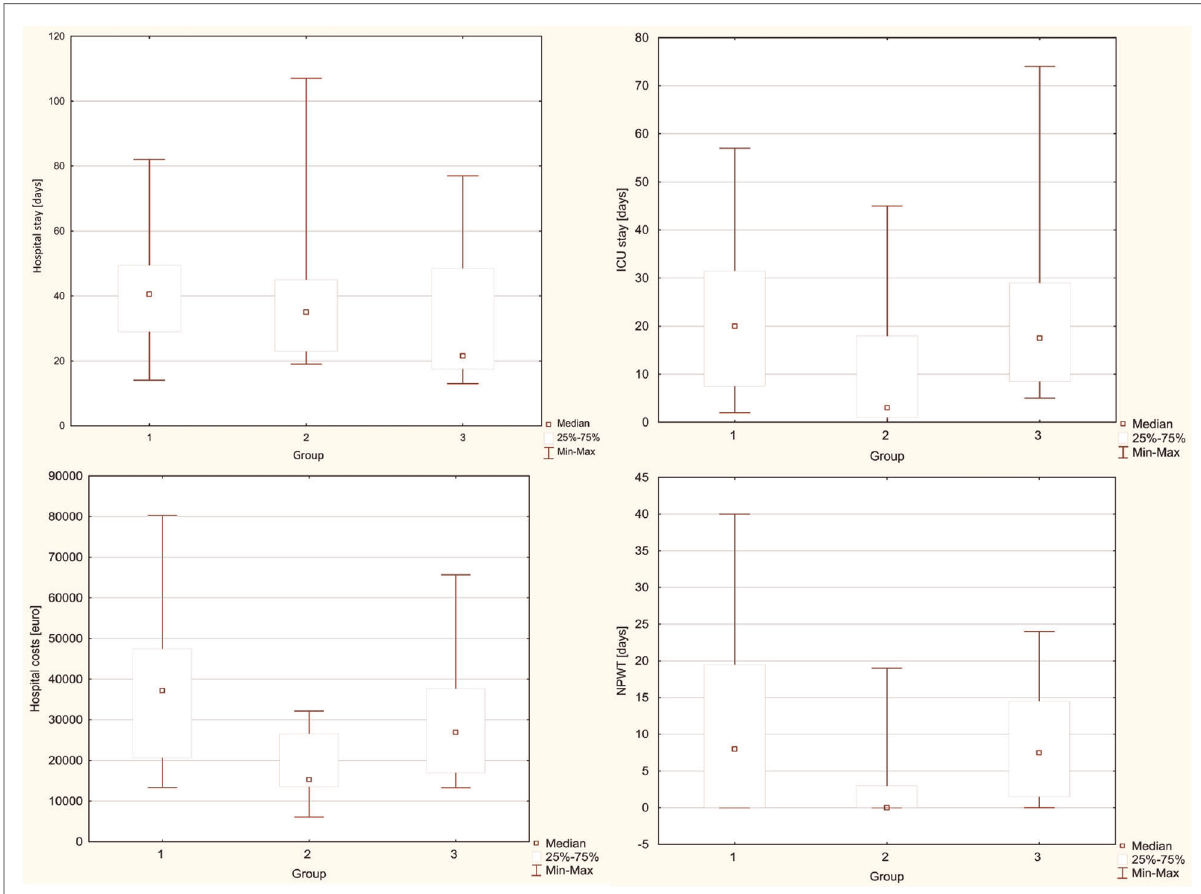
FIGURE 1 Boxplots comparing the individual monitored parameters between the groups. Group 1: PJA disconnection group; Group 2: Simple drainage group; Group 3: Total pancreatectomy